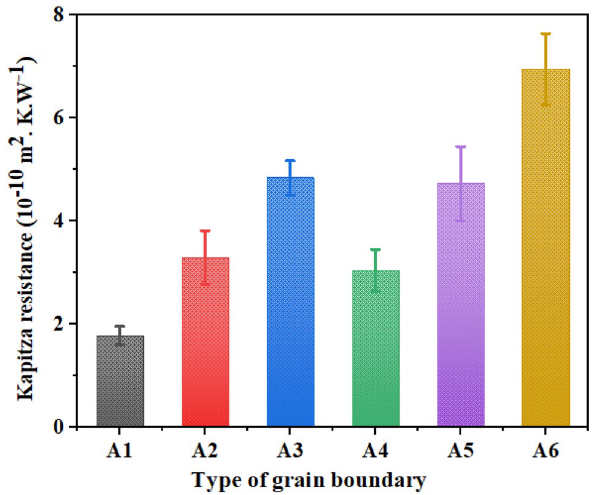
Figure 6. The interfacial thermal resistance (Kapitza resistance) of various constructed grain boundaries A 1 (5–7–6–6–s),